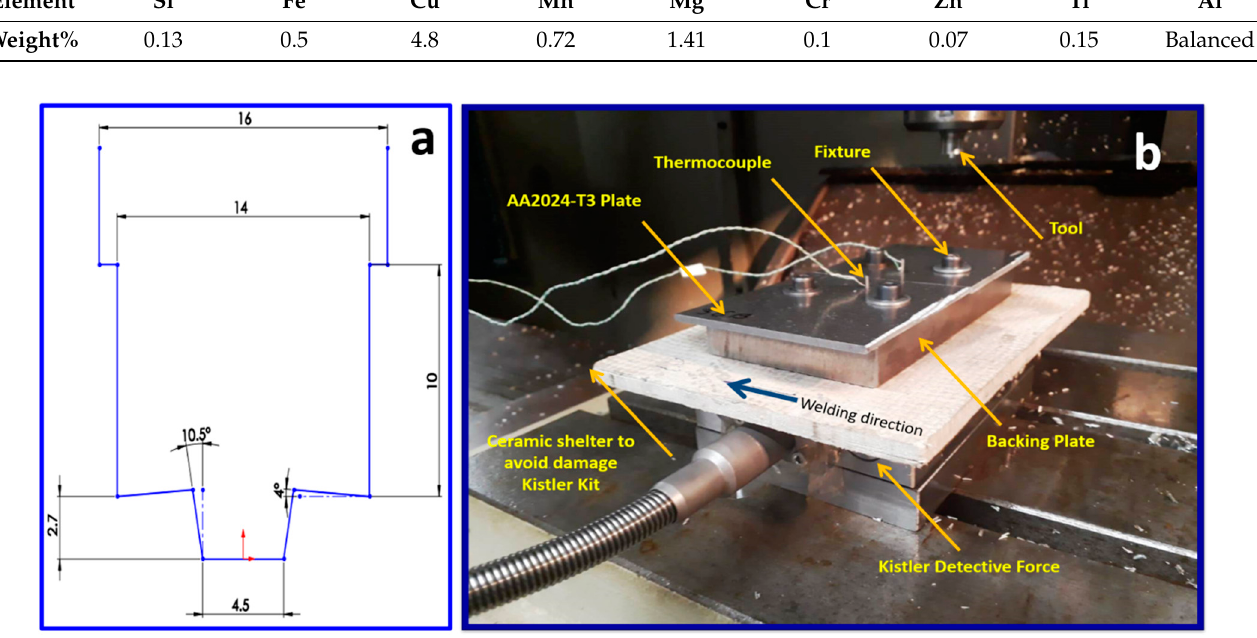
Figure 1. ( a ) Dimensions of FSW tool (mm); ( b ) set up for FSW process (reproduced and adopted from [15] with permission from Springer, 2022).